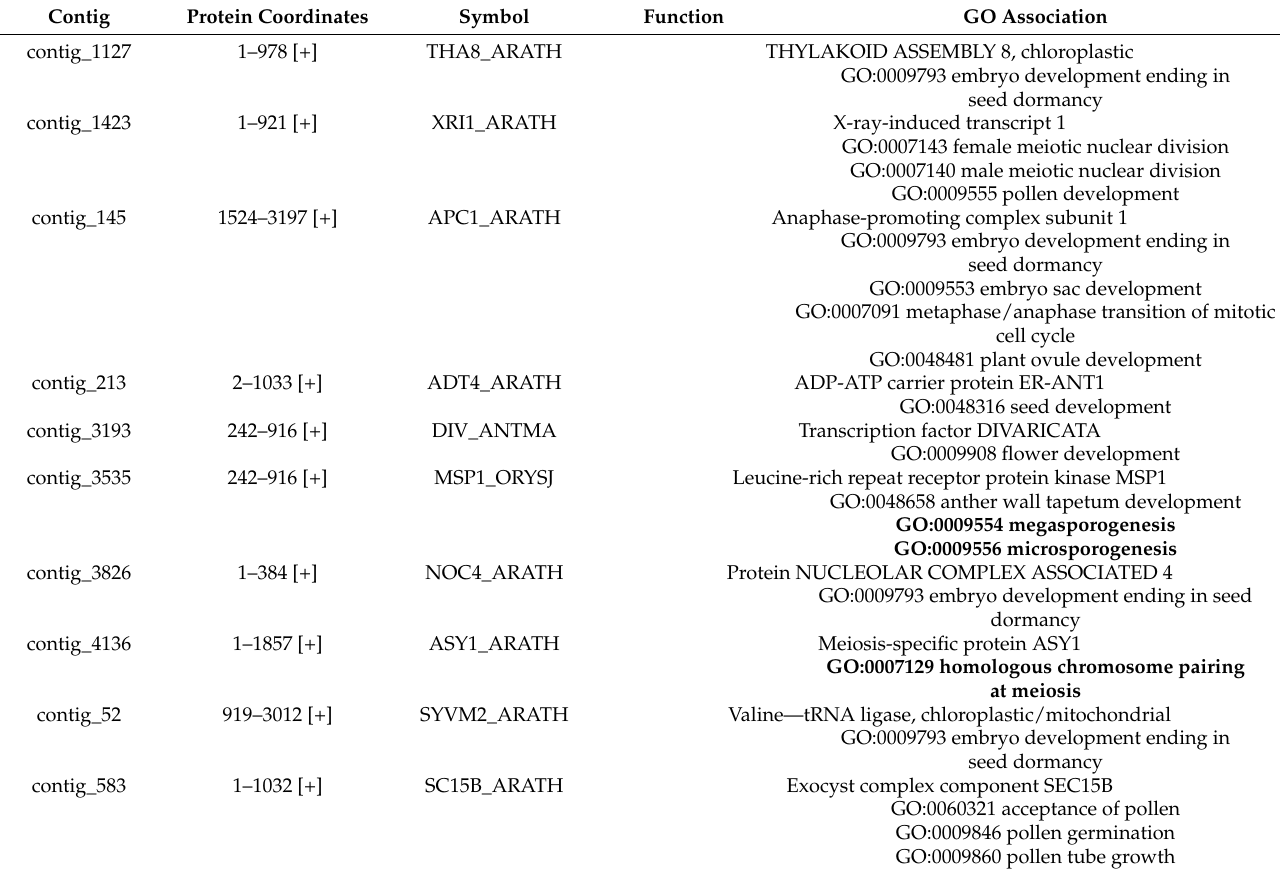
Table 3. Functional annotation of putative single-copy genes subjected to diversifying selection in pairwise comparisons between the F2 hybrid and the parental individuals, which are linked to reproduction with the coordinates of the coded proteins in the transcript. The functional annotation based on UniProt is given with the symbol and organism of the reference gene, and the most general (top-level) GO term(s) for their functional involvement in the reproductive process. Reference organism: ARATH: Arabidopsis thaliana . ORYSJ: Oryza sativa japonica. GO terms also found by [30] under strong diversifying selection between apomictic and sexual R. auricomus lineages are marked in